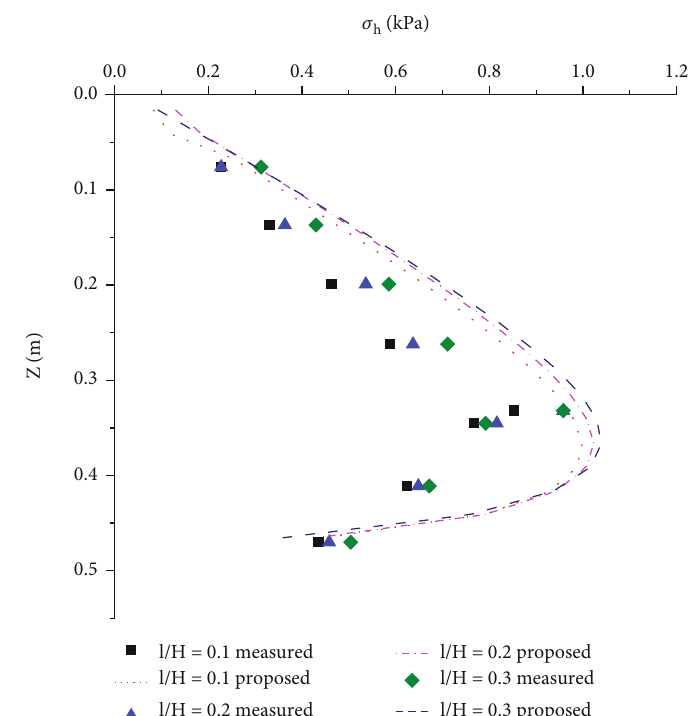
Figure 7: Comparison of the proposed model ’ s results and the experimental validation of the laboratory